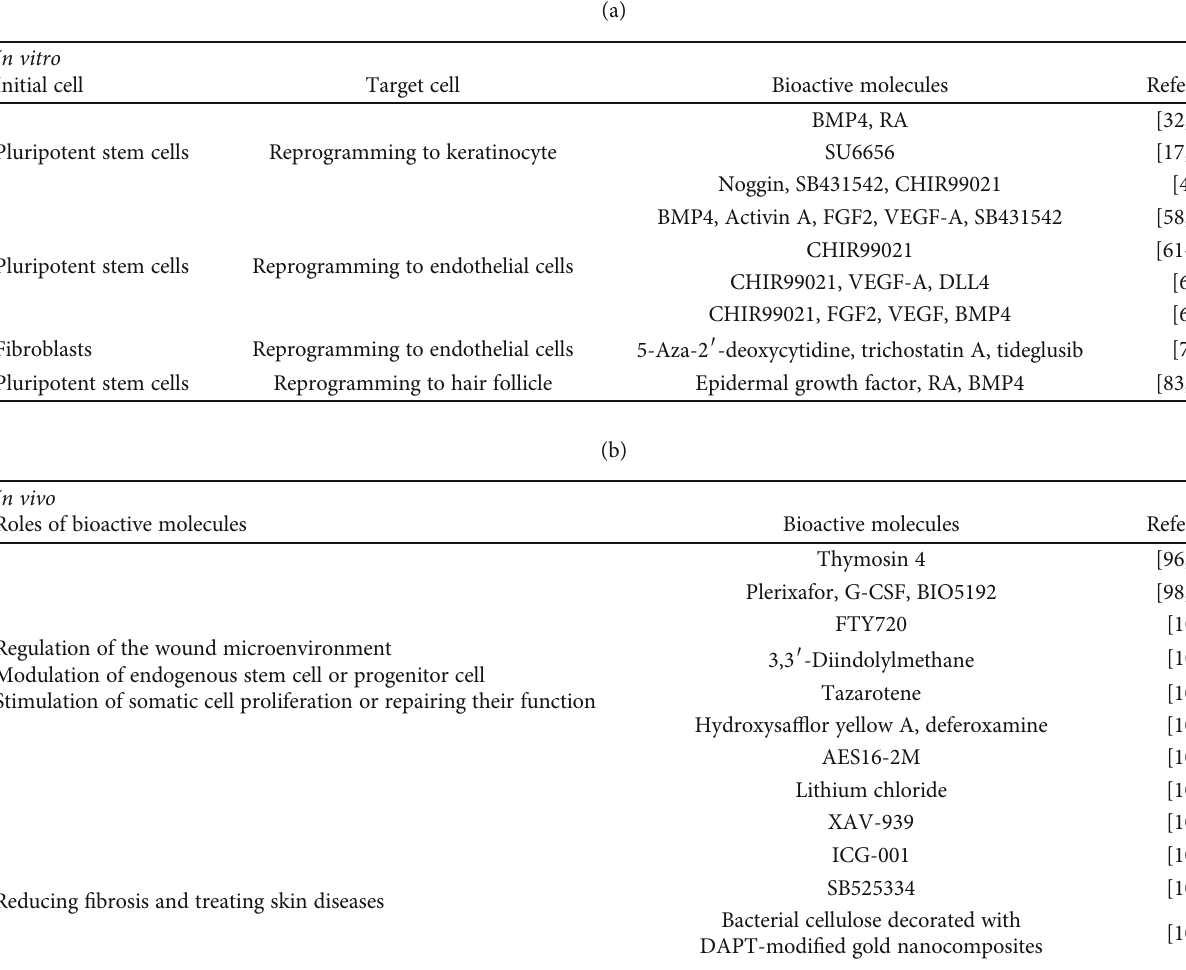
Table 1: Bioactive molecules for skin repair and